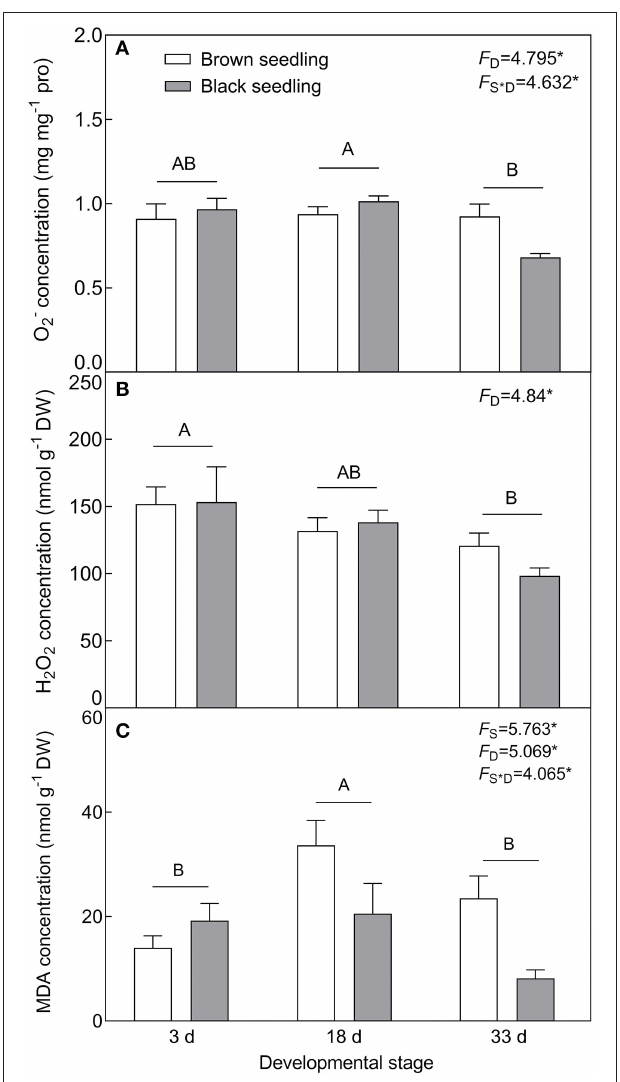
FIGURE 6 | Changes in the ROS level and MDA concentration during seedling development. (A) O 2 − , (B) H 2 O 2 , and (C) MDA. 3 d, 18 d, and 33 d: represent 3, 18, and 33 days after seedling emergence, respectively. F -values are given when significance levels are reached (the subscript “D” represents “development”; “S”, “seed type”; * P < 0.05). Bars with different uppercase letters indicate significant differences ( P < 0.05) according to Tukey’s test. Values are means ± SE of four replicates.